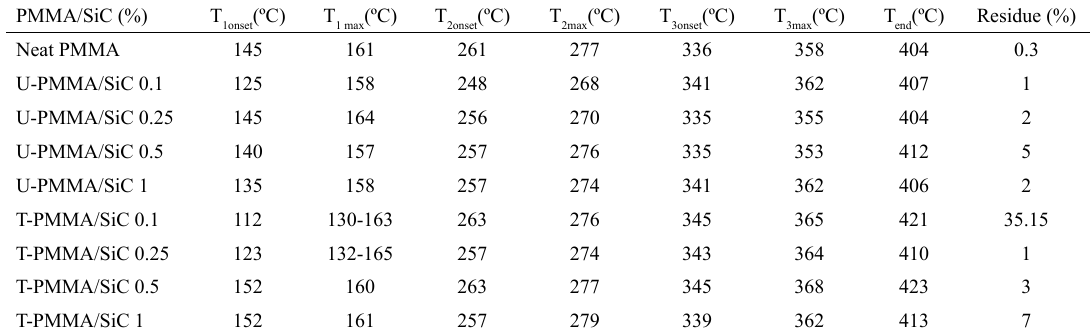
Table 2. Thermogravimetry analysis of the PMMA polymer and synthesized nanocomposites treated and untreated with vinyl trimethoxy silane